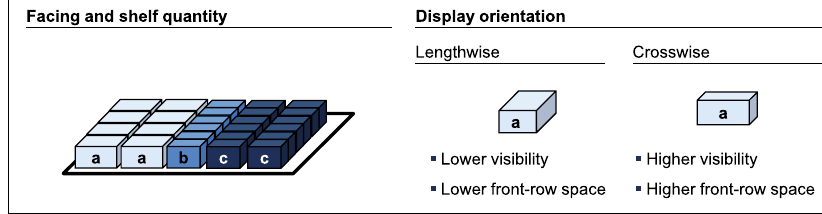
Fig. 1 Illustration of facing, shelf quantity and display